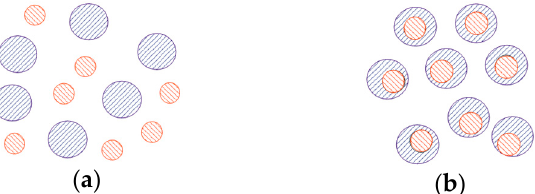
Figure 1. Differences between mixture of two aqueous dispersions of different polymers (polymer 1—blue color and polymer 2—red color) and aqueous dispersion with hybrid particle structure composed of the same two different polymers. In the mixture of two dispersions ( a ) synergistic effect is much less probable than in dispersion with hybrid particle structure ( b ) [4].